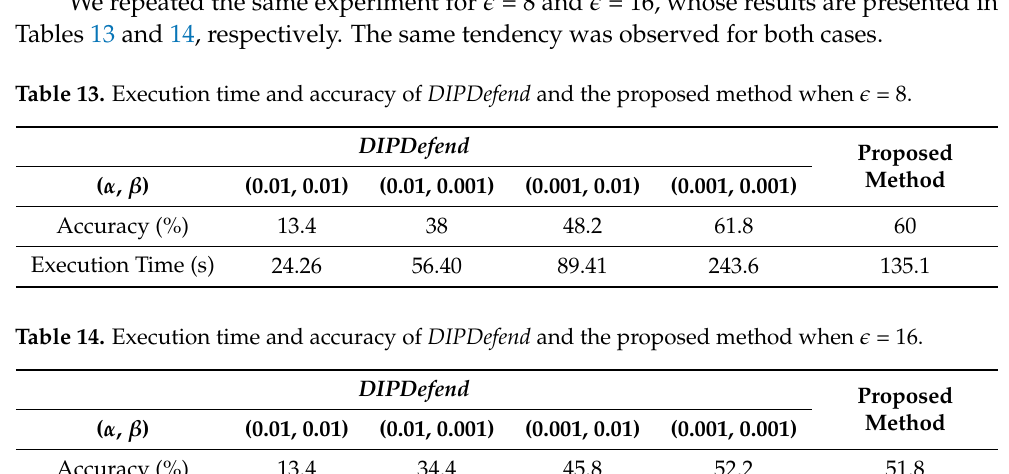
Table 15. Comparison between DIPDefend and the proposed method with adversarial examples.